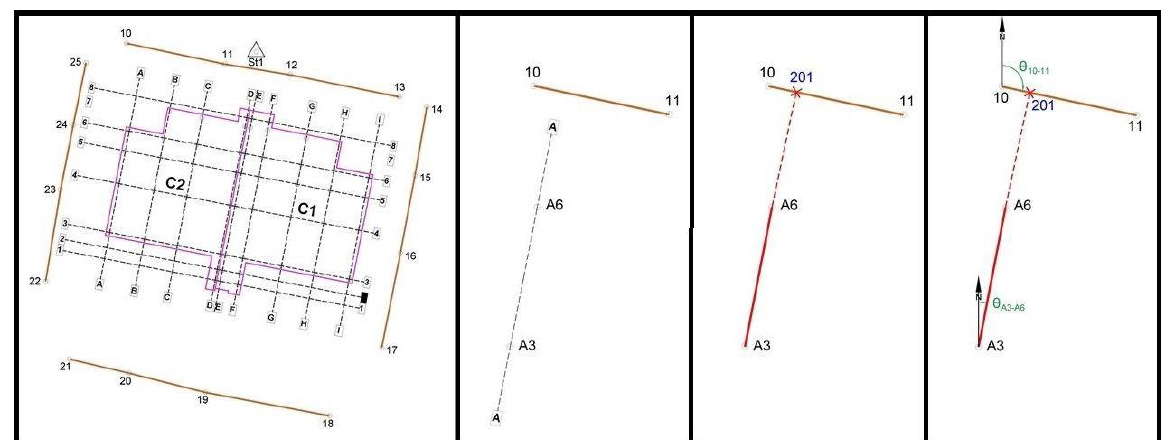
Figure 11. Construction lines and batter boards intersection.